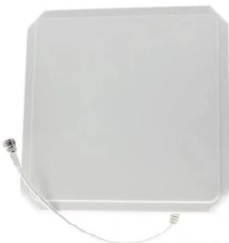
Figure 9. UHF circularly polarized antenna.